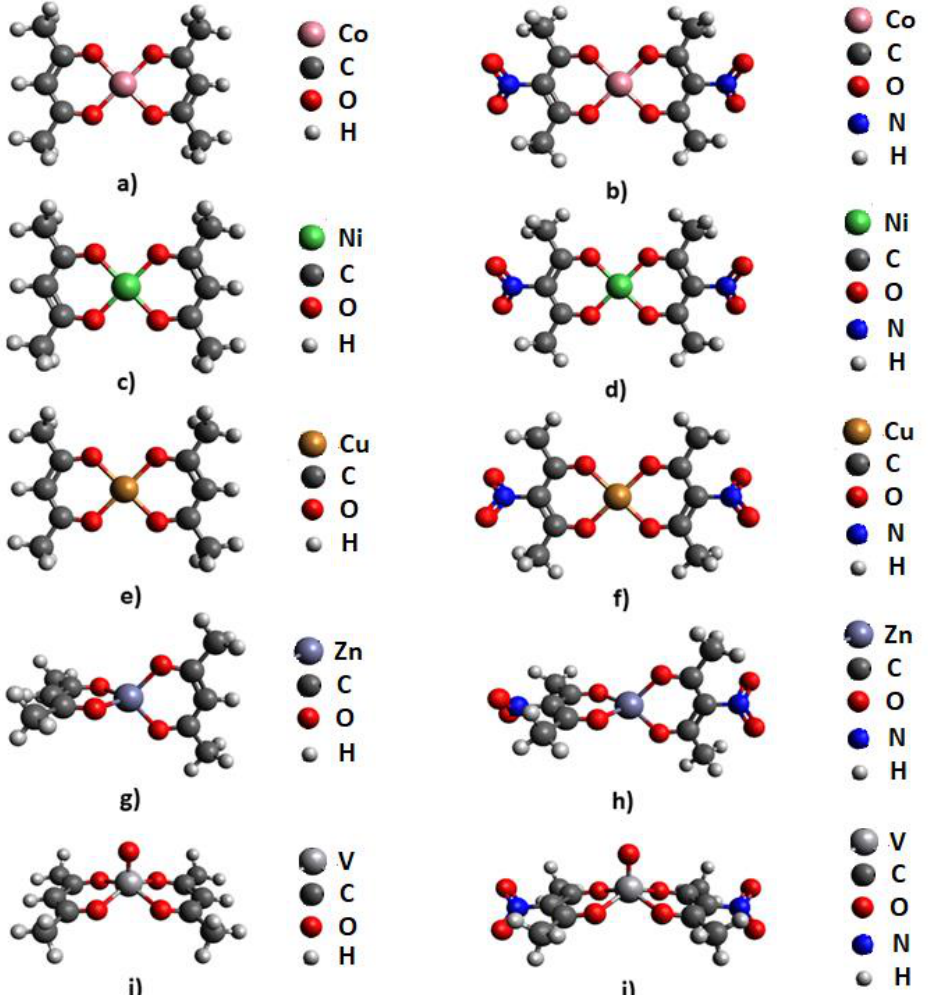
Figure 1. Optimized geometries for: ( a ) bis(acetylacetonato) cobalt (II), ( b ) nitro-bis(acetylacetonato) cobalt (II), ( c ) bis(acetylacetonato) nickel (II), ( d ) nitro-bis(acetylacetonato) nickel (II), ( e ) bis(acetylacetonato) copper (II), ( f ) nitro-bis(acetylacetonato) copper (II), ( g ) bis(acetylacetonato) zinc (II), ( h ) nitro-bis(acetylacetonato) zinc (II), ( i ) bis(acetylacetonato) oxovanadium (IV), and ( j ) nitro-bis(acetylacetonato) oxovanadium